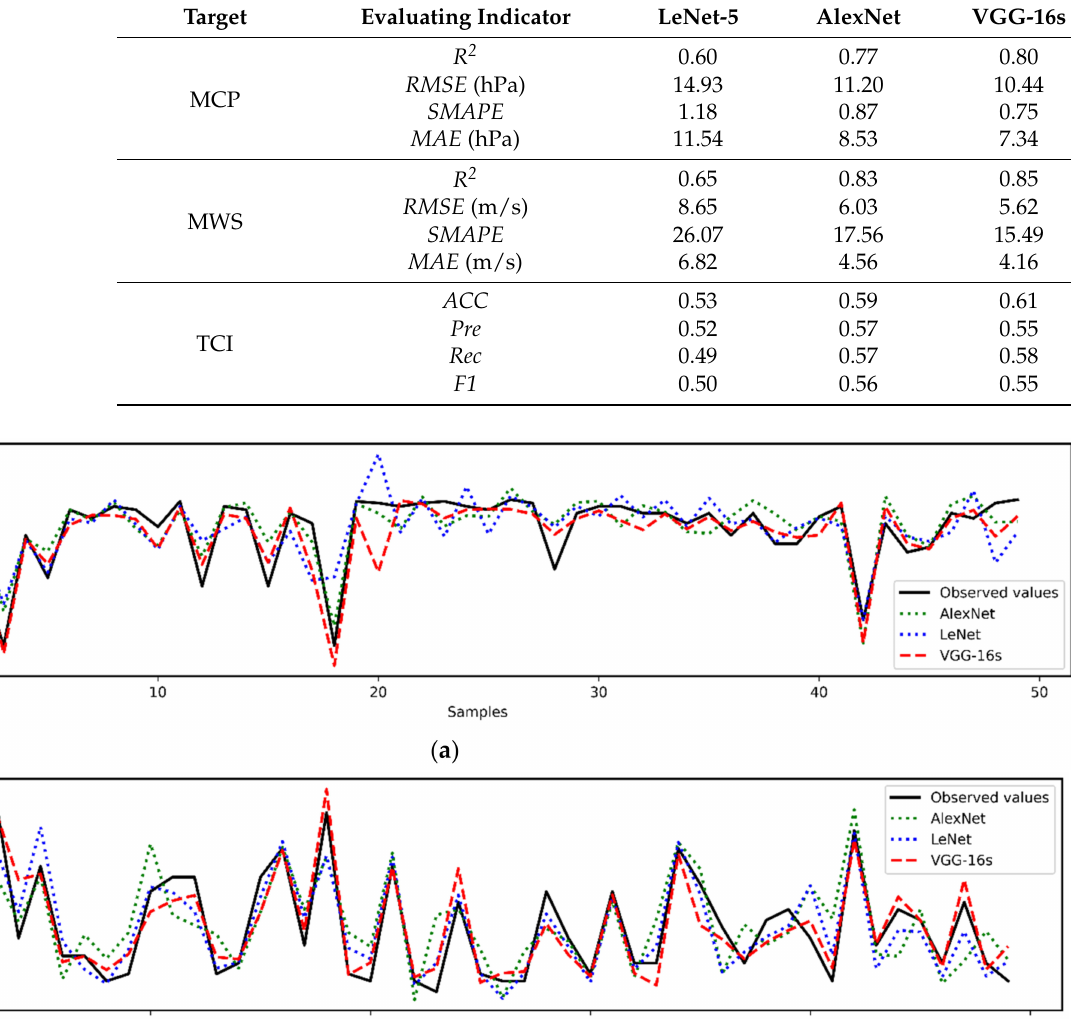
Table 3. The performance of three models in stimulating MCP, MWS, and TCI.